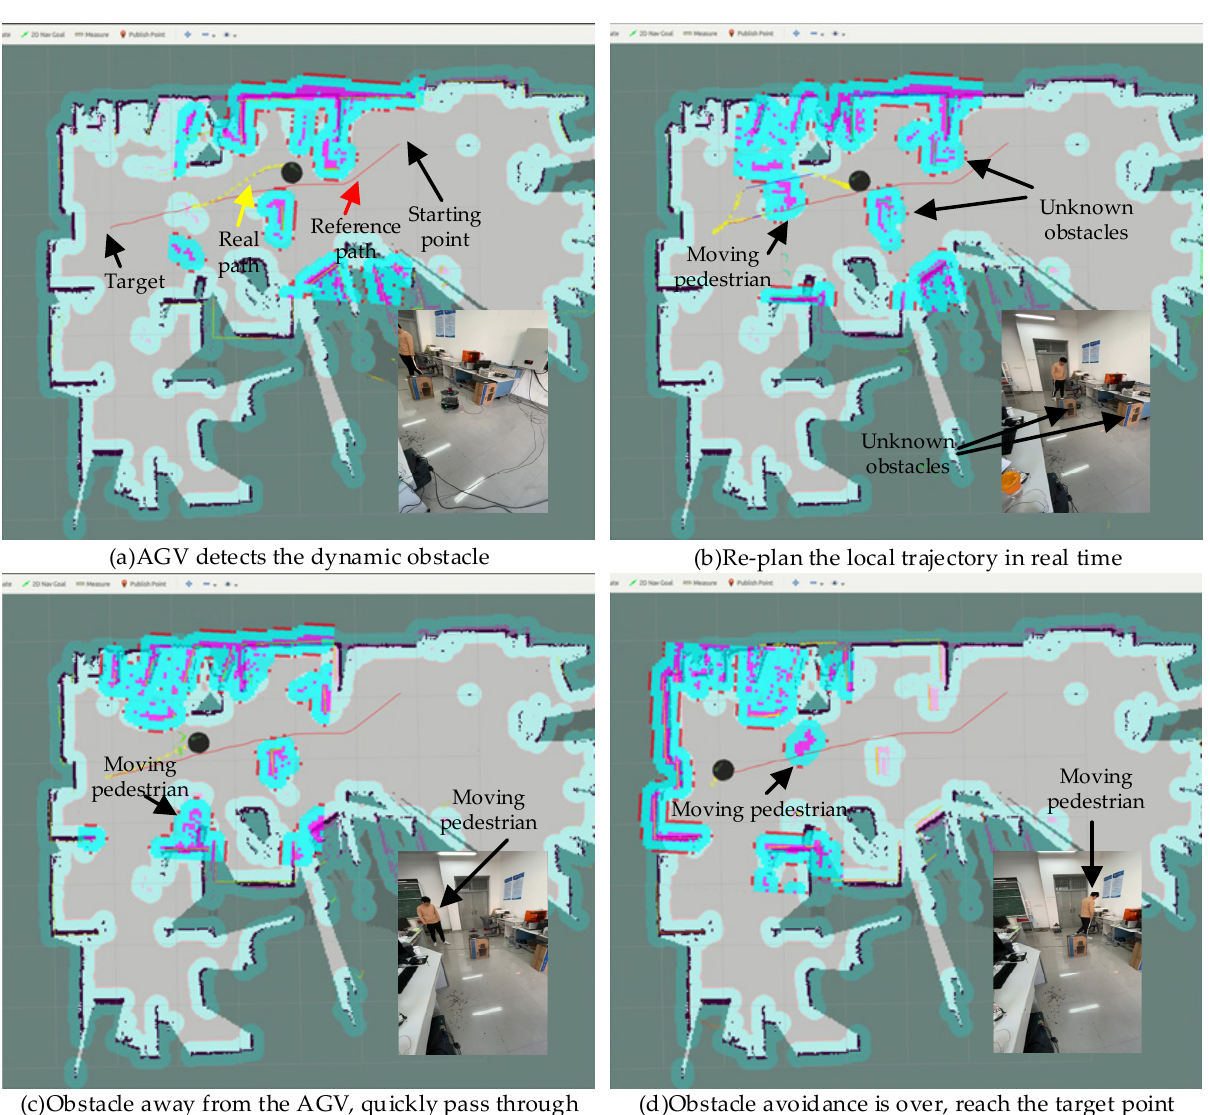
Figure 9. The process of AGV movement in the environment with the unknown dynamic obstacle.